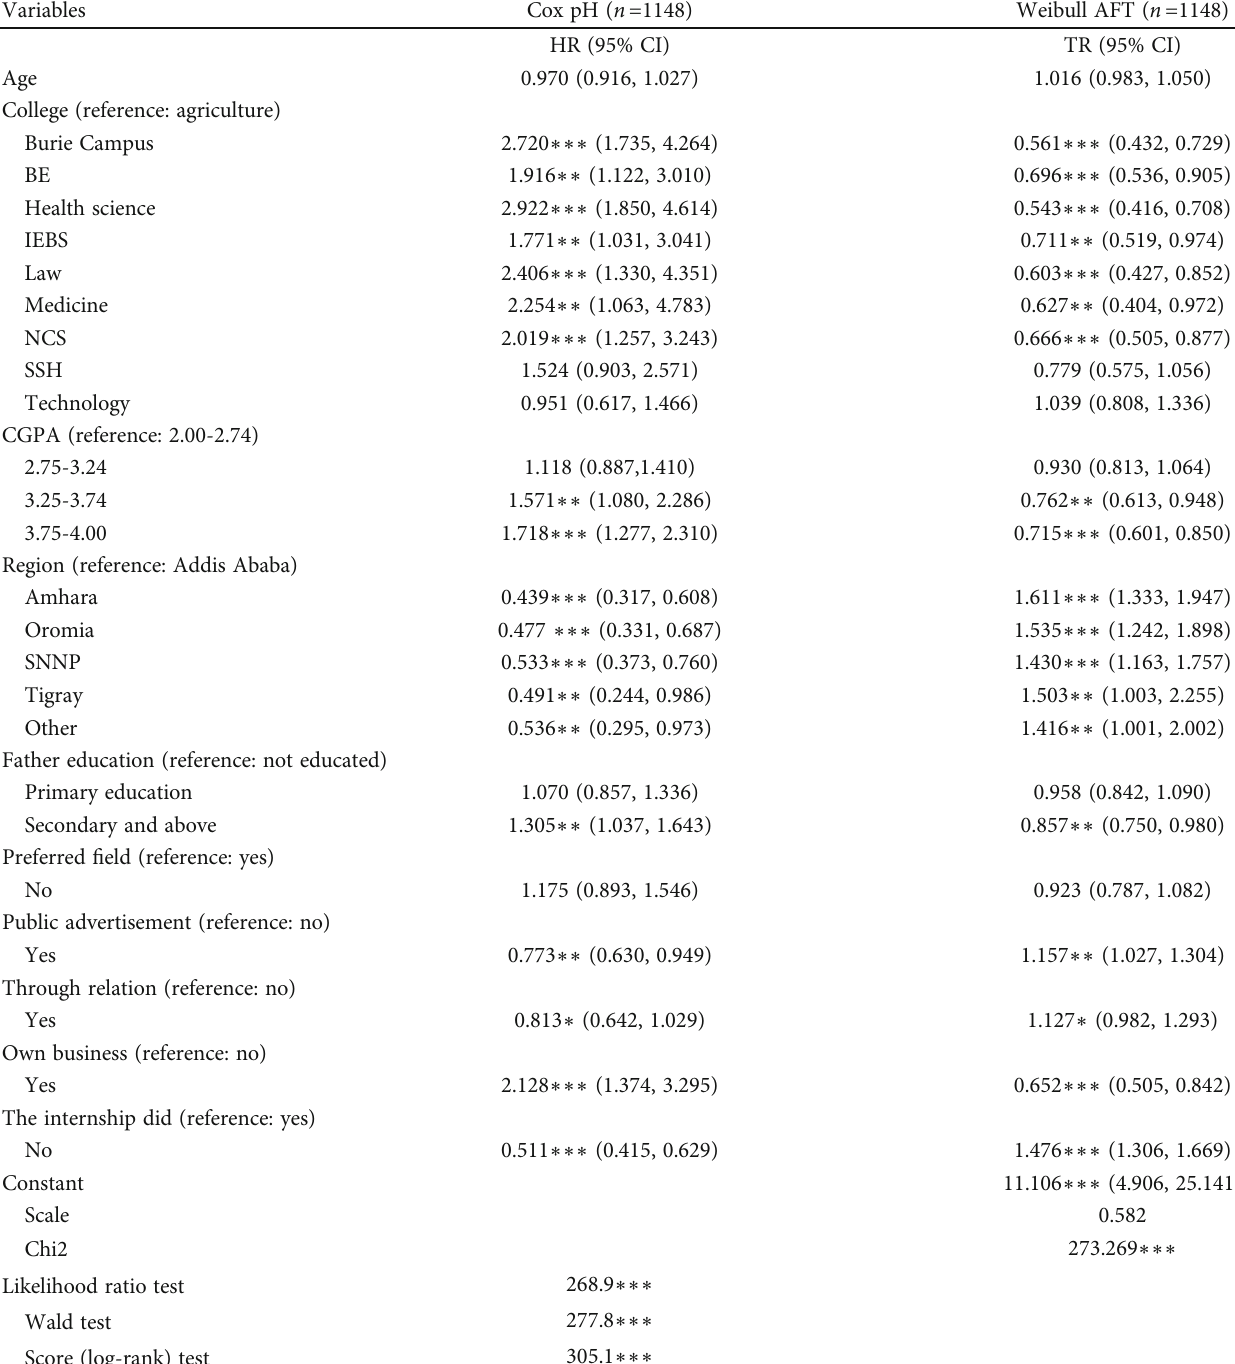
Table 2: Results of fi tting the Cox pH model and the Weibull AFT model for graduates